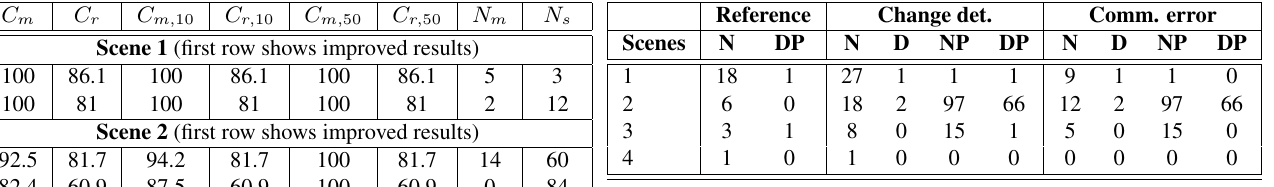
Table 4: Change detection results with removal of commission errors > 9 m 2 in area . N = new buildings, D = demolished